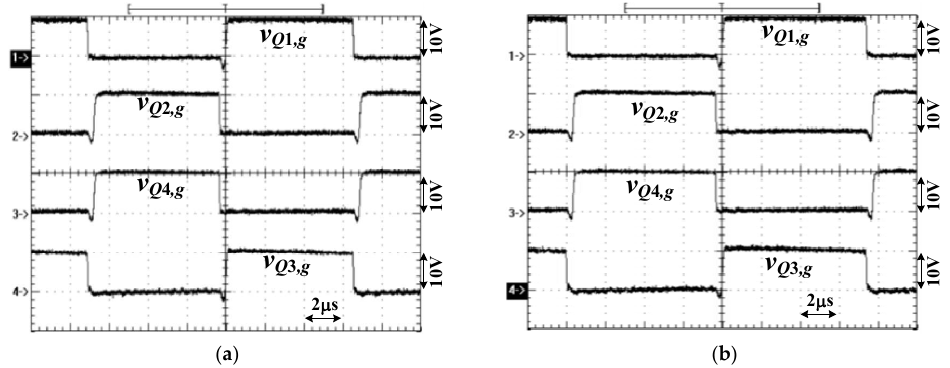
Figure 8. Test results of v Q 1, g ~ v Q 4, g at ( a ) 50% power and ( b ) rated power.